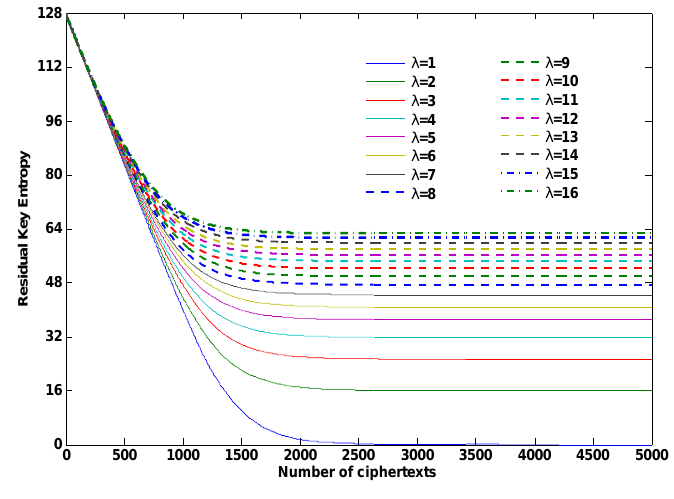
Figure 3: Relationship among the residual key entropy, N and λ